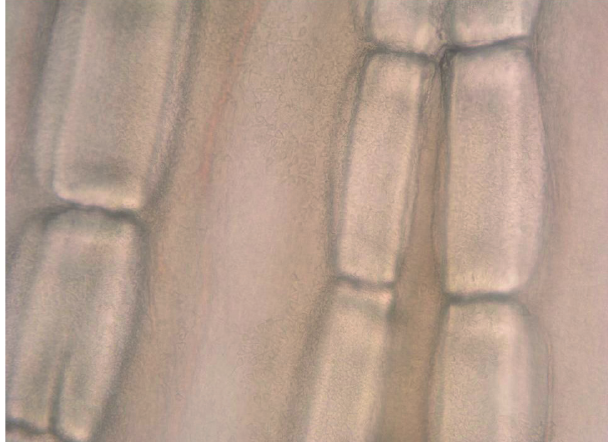
Fig. 4. Detail of the caudal-fin of a DOPA(–) albino specimen of T. itacarambiensis , not treated with DOPA. Magnification 200